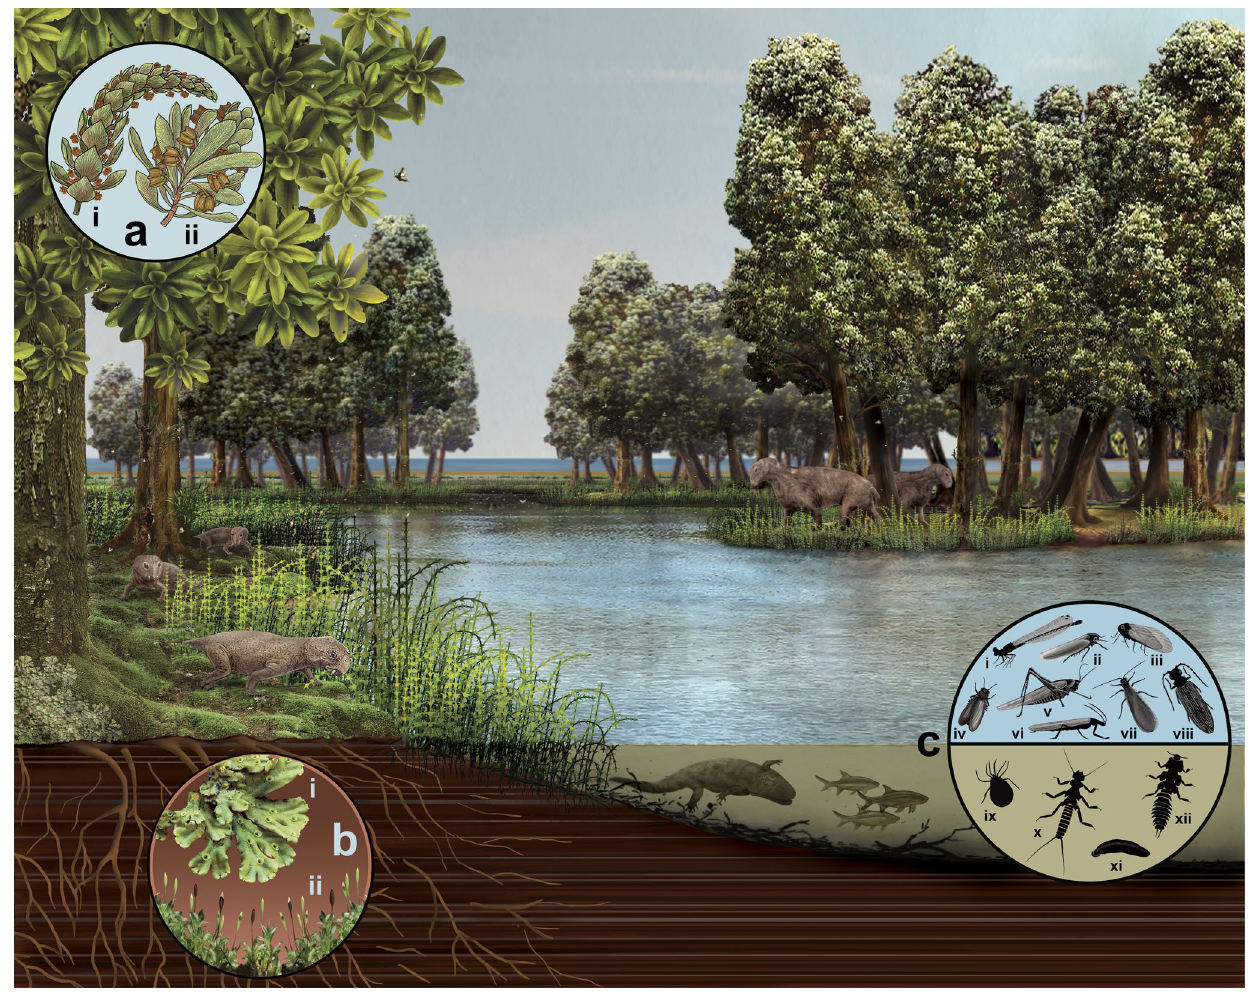
Fig. 6 Reconstruction of a middle Permian lakeshore palaeoenvironment. This reconstruction is based on new fossil information from the Onder Karoo Lagerstätte and regional occurrences of the vertebrates of the Eodicynodon Assemblage Zone in the southern Karoo Basin. The landscape is of a standing body of water, probably a pool, on the delta plain of a river as it enters the Karoo Sea (seen in the distance). Trees are Glossopteris , with buttress roots, epicormics shoots on the trunks, and leaves borne in whorls (with evidence of insect damage). Delicate horsetails of the genus Phyllotheca line the edges of the water bodies, and colonize the surrounding marshes. The large vertebrates in the middle distance are the therapsids Tapinocaninus , those in the foreground are the dicynodont Eodicynodon . Beneath the surface of the water, a Rhinesuchus amphibian can be seen hunting Namaichthys fi sh. Inset, a male (i) and female (ii) reproductive cones of the Glossopteris plant; b bryophytes: thallose liverwort (i), moss gametophytes with sporophytes (ii); c terrestrial insects: (i) protozygopteran (damsel fl y predecessor); (ii) auchenorrhynchan (leafhopper); (iii) Prosbolid hemipteran; (iv) protelytopteran;